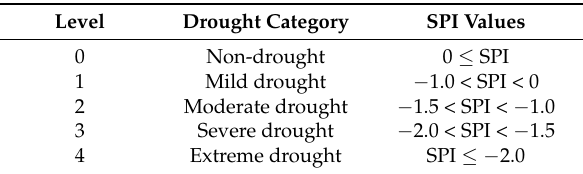
Table 3. Drought classification using the SPI index